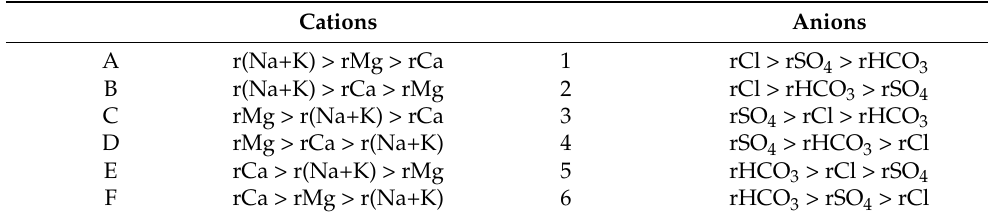
Table 6. Water type according to Schoeller classification.